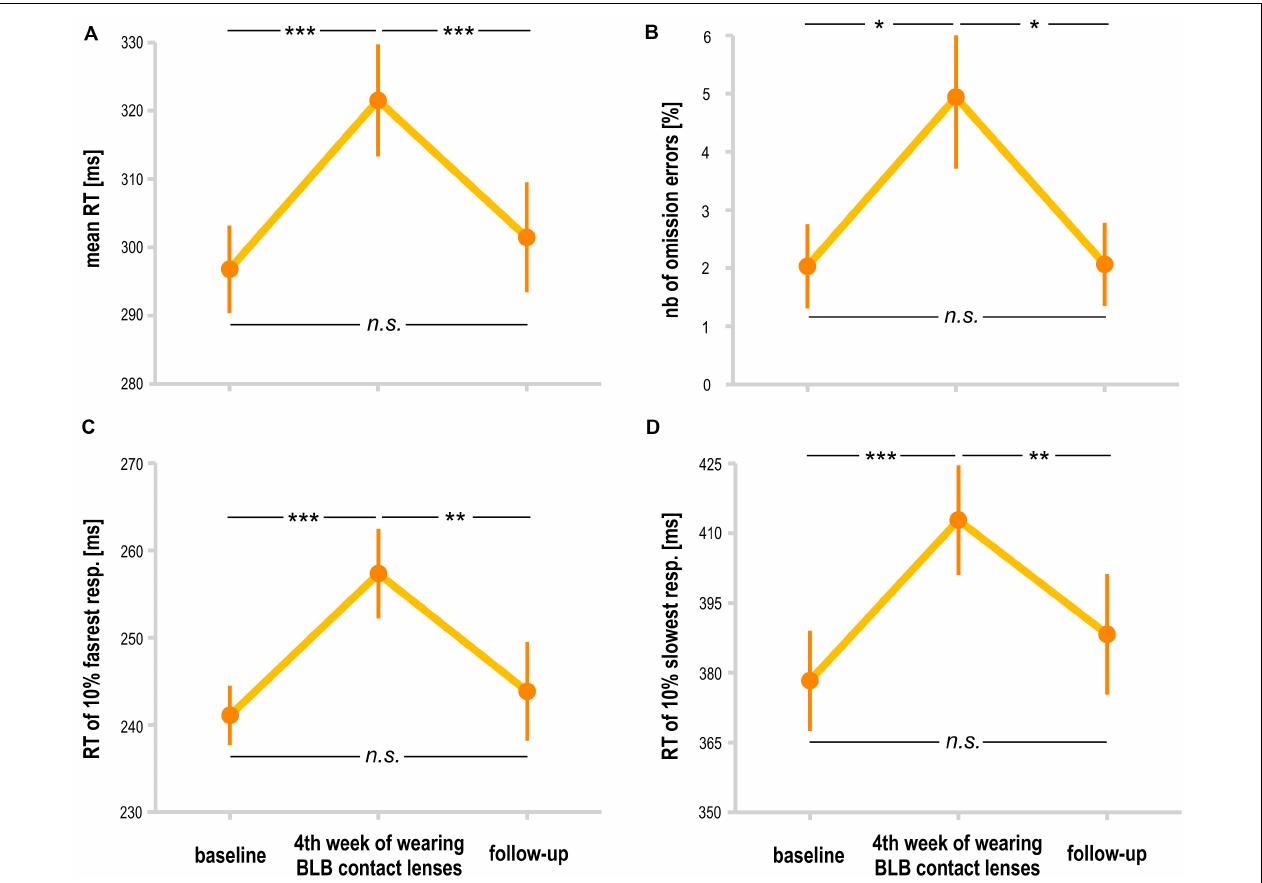
FIGURE 5 | Comparison of psychomotor vigilance task (PVT) outcomes for the blue light blocked (BLB) group between baseline, fourth week of blue light reduction, and the follow-up session: (A) mean reaction time, (B) number of omission errors, (C) reaction time for 10% of the fastest responses, and (D) reaction time for 10% of the slowest responses. *** p < 0.001; ** p < 0.01; * p < 0.05; bars indicate standard